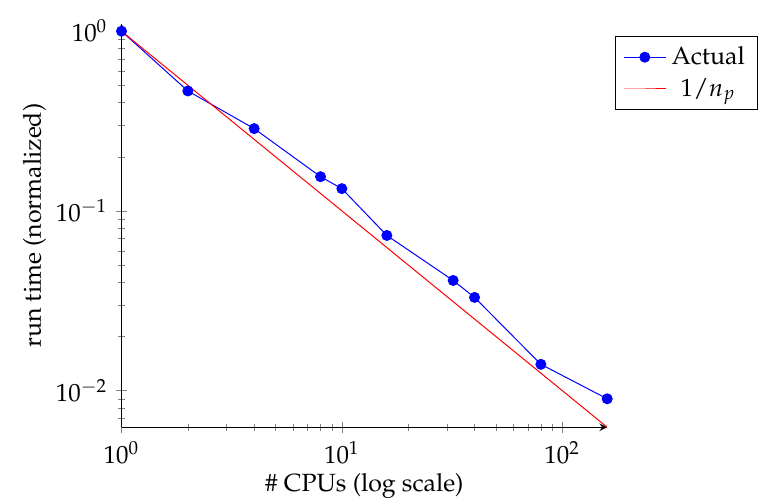
Figure 7. Normalized runtime using MPI versus number of CPUs ( n p ). The option is identical to the no volume choice swing option with a five-dimensional underlying considered in Section 2.4.3. The branching factor used is b =